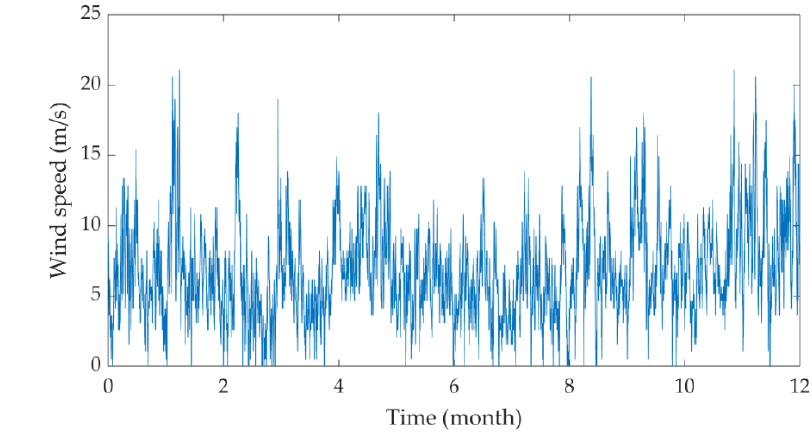
Appl. Sci. 2019 , 9 , x FOR PEER REVIEW